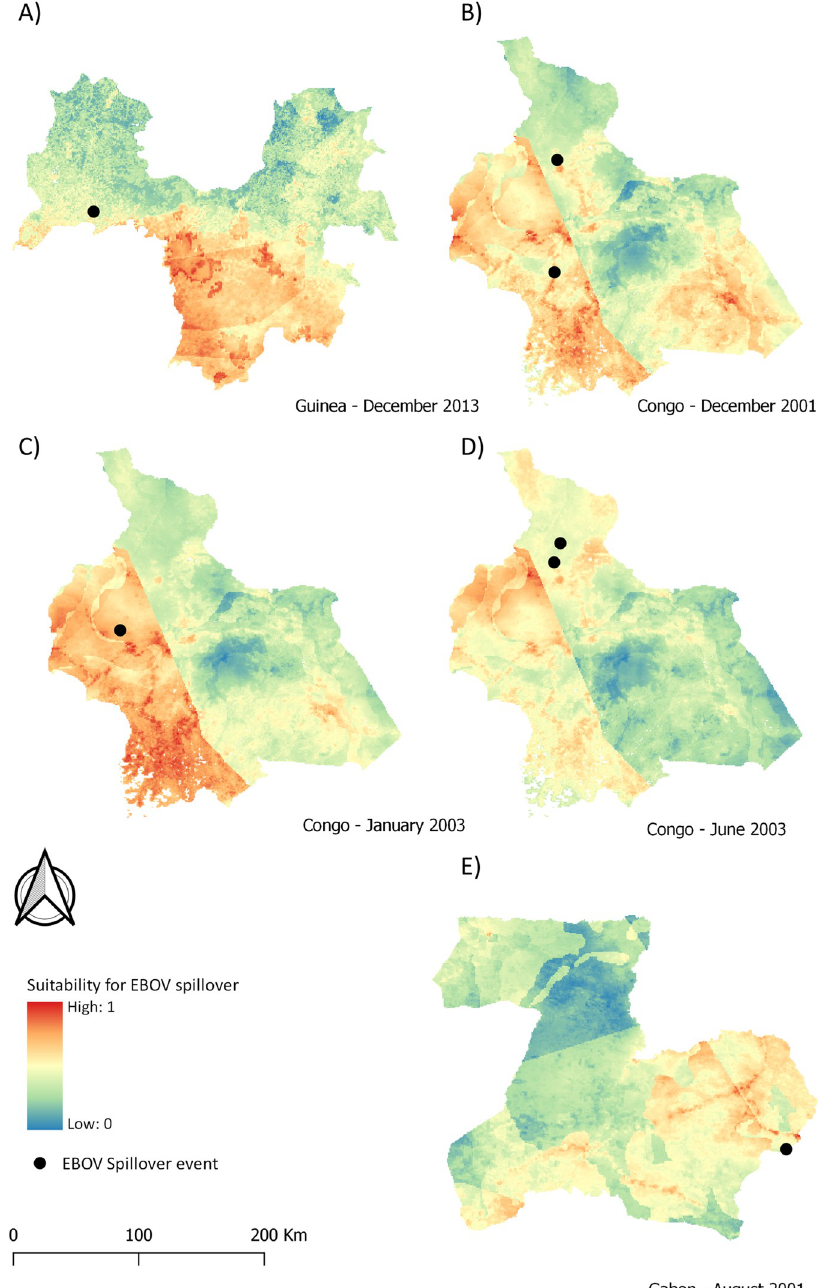
Fig 4. Suitability maps for EBOV spillover in areas in Guinea (A), Congo (B-D) and Gabon (E) (dataset available at https://doi:10.18167/DVN1/FZANMS).